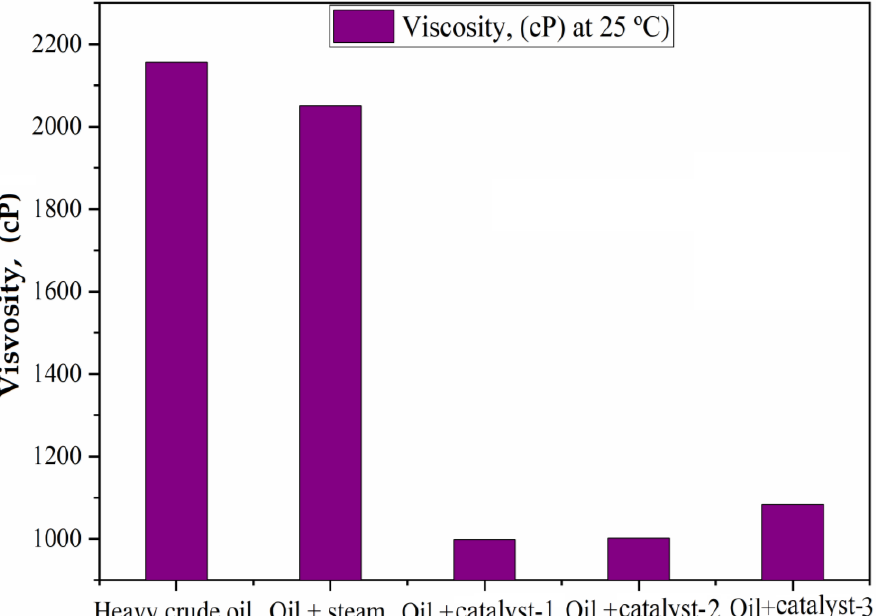
Figure 8. Viscosity of heavy oil and upgraded oil samples.